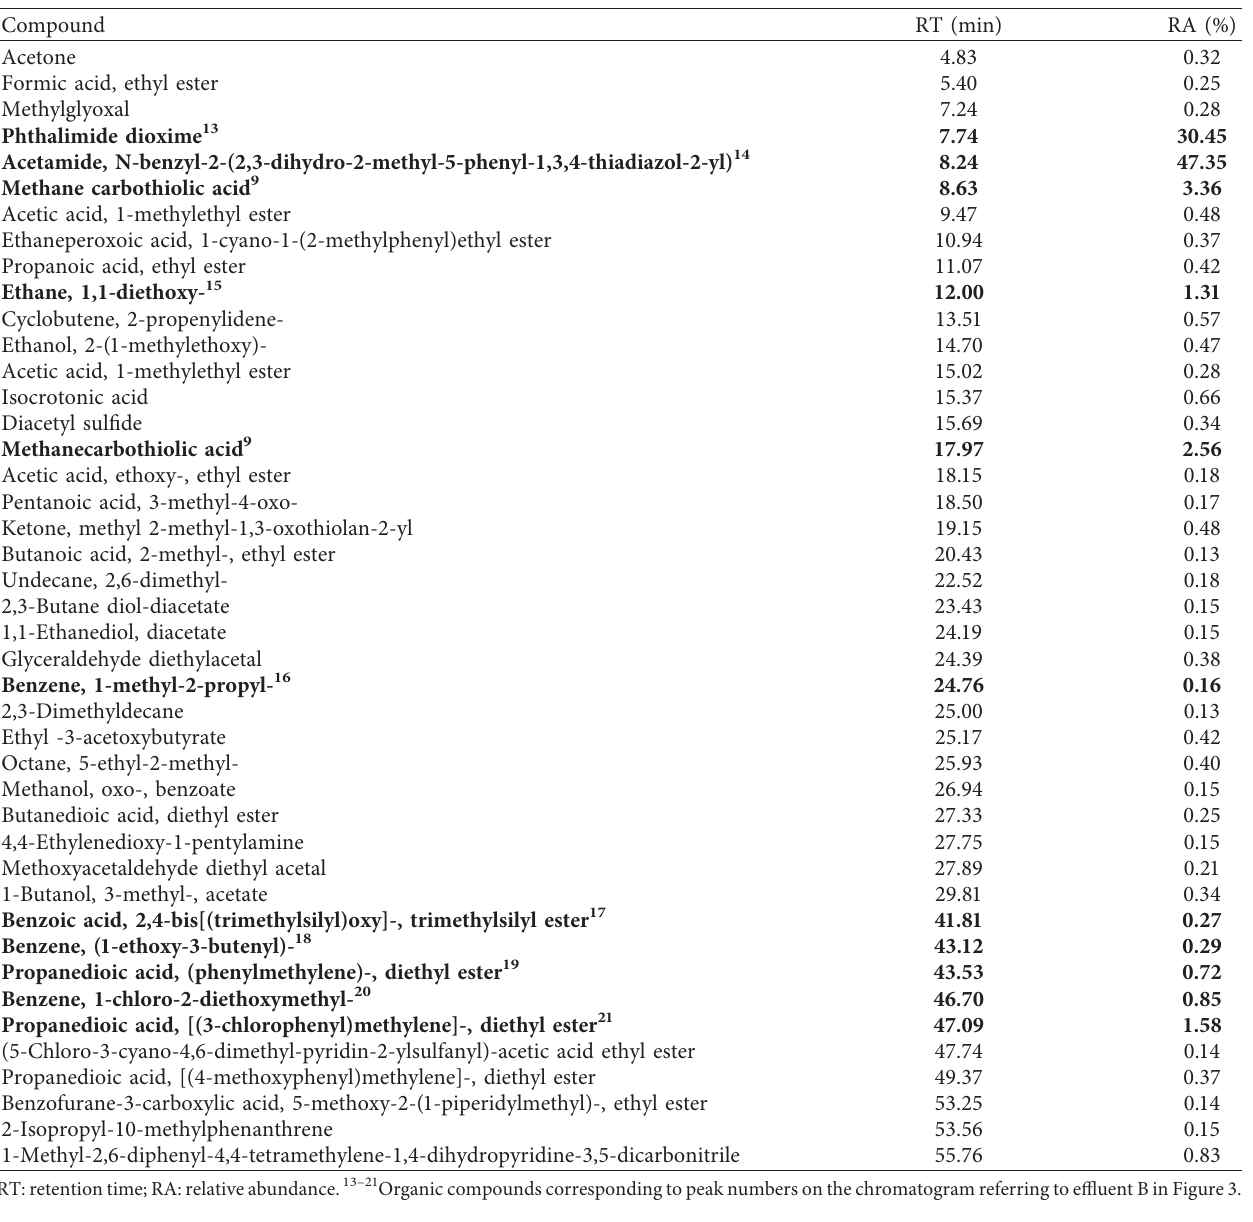
Table 3: Organic compounds identified in real textile effluent